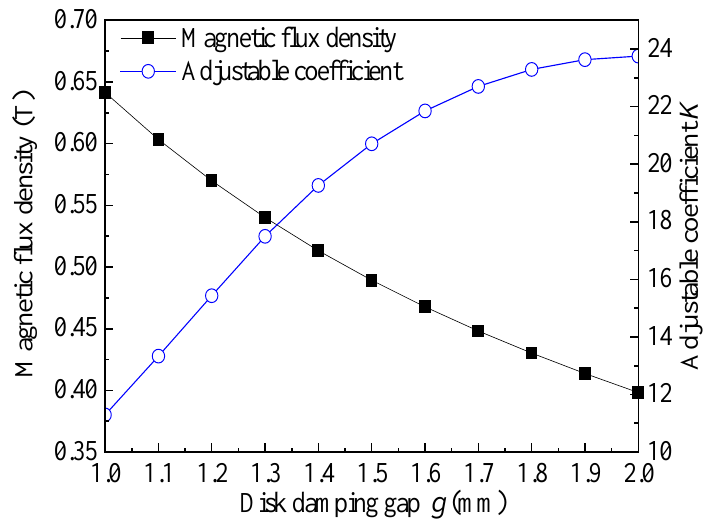
Figure 13. Magnetic flux density and adjustable coefficient under different disk damping gap.